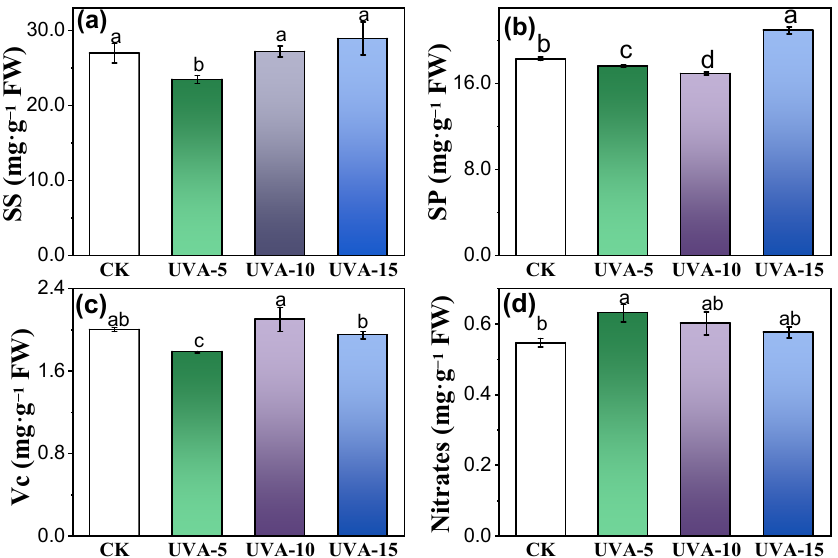
Figure 4. Nutritional compounds of Chinese kale baby-leaves under different supplemental UV-A intensity. ( a ) SS = soluble sugars, ( b ) SP = soluble protein, ( c ) Vc = vitamin C, ( d ) nitrate. The results presented were means ± standard error ( n = 3). Different letters ( a – d ) on the bar plots indicate significant difference at p < 0.05 using one-way analysis of variance with Duncan’s multiple-range test.